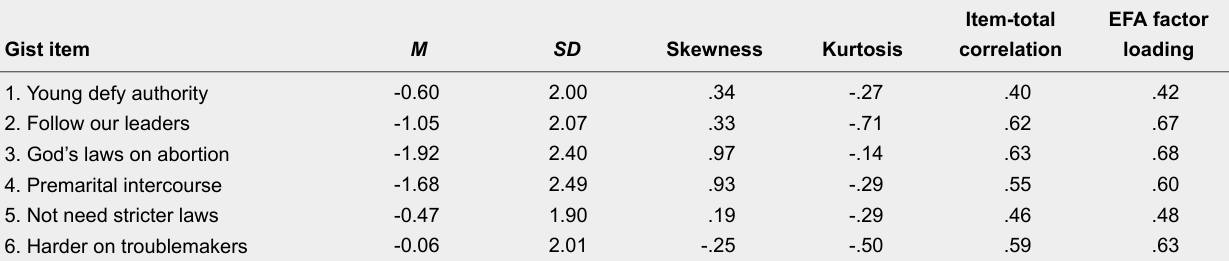
Descriptive Item Statistics, Item-Total Correlations and EFA Factor Loadings for the Six VSA Items in Study 1 (N =